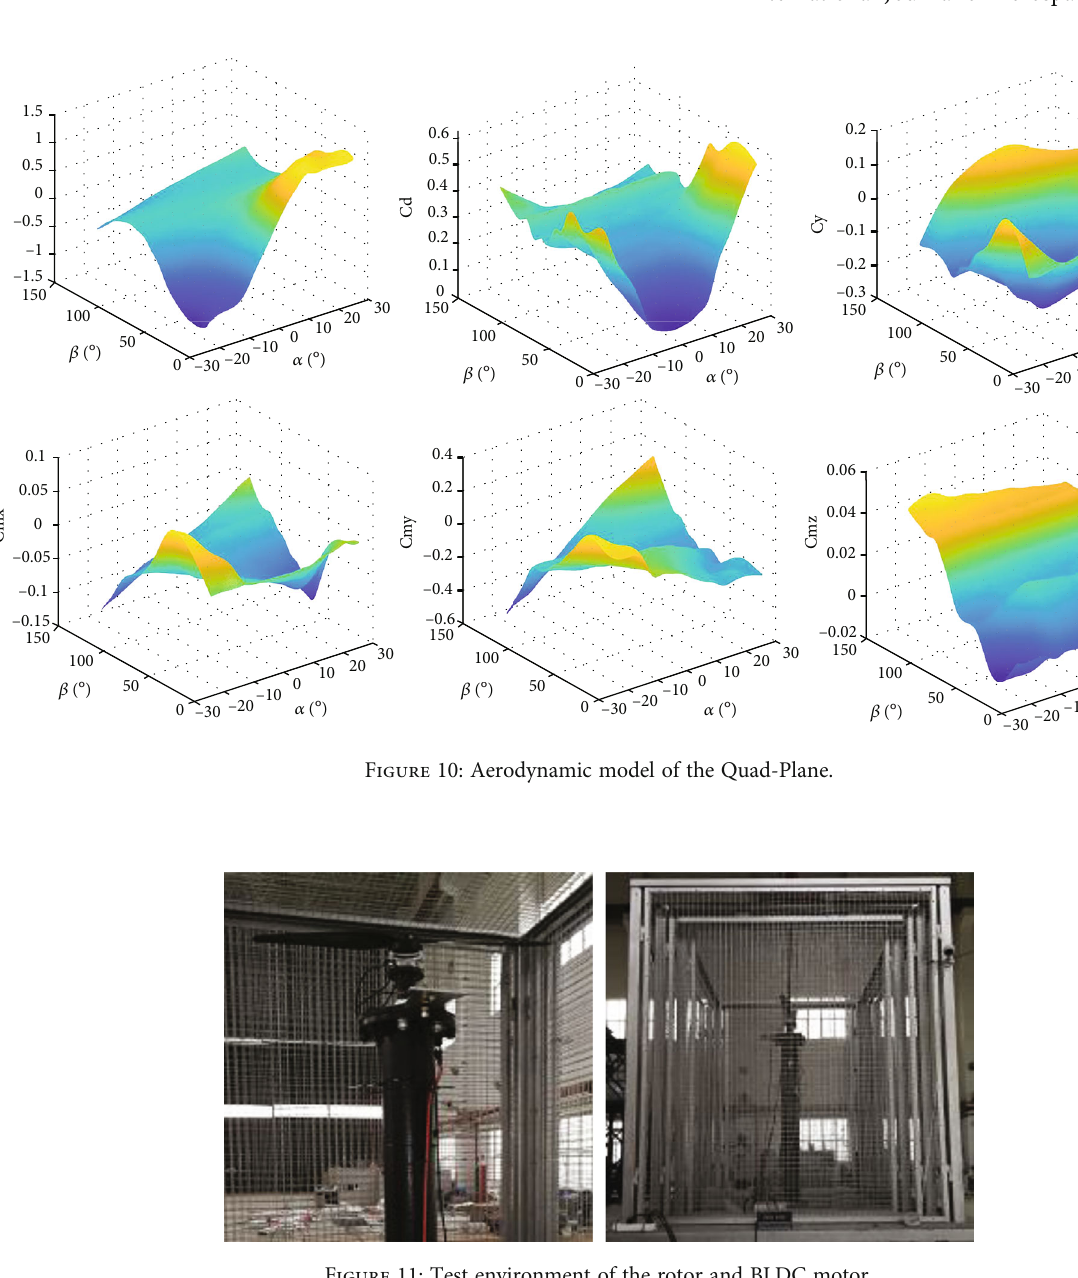
Figure 11: Test environment of the rotor and BLDC